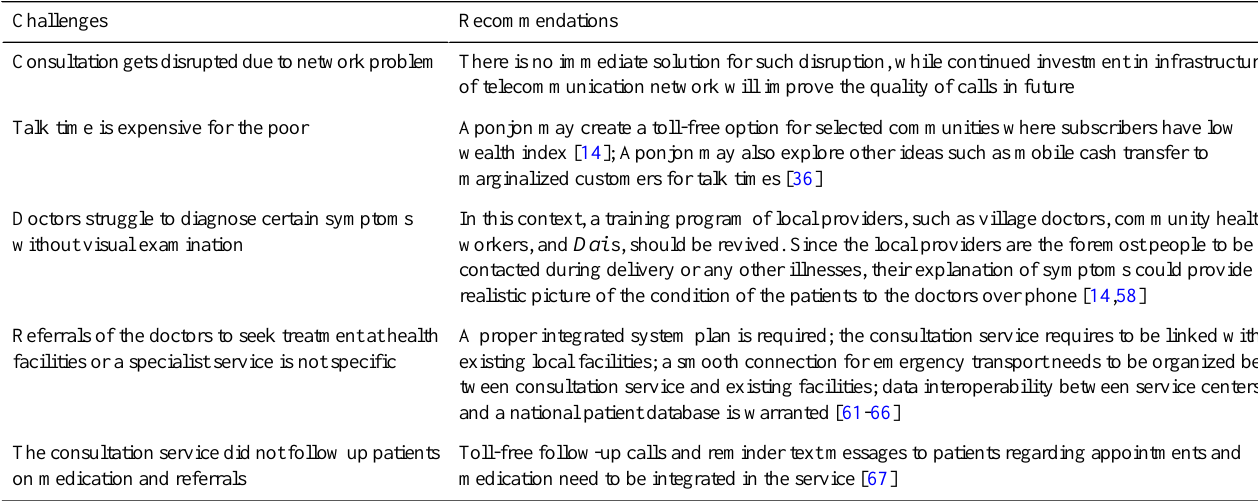
Table 7. Identified challenges and